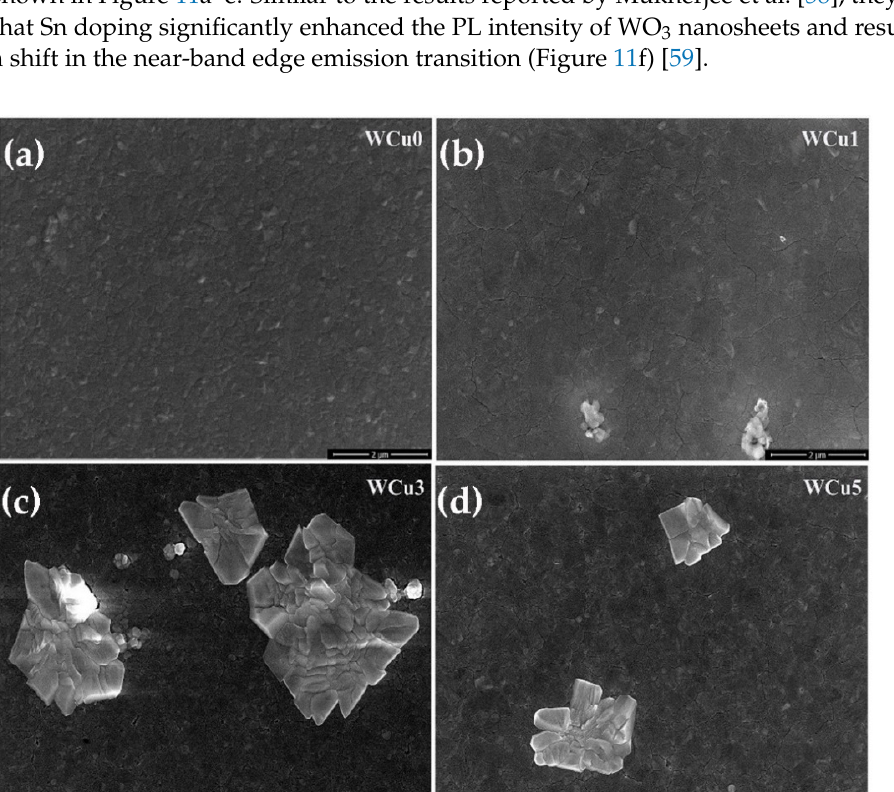
Figure 10. ( a – e ) FESEM images and ( f ) Photoluminescence emission spectra of the undoped and Cu doped WO 3 thin films. Reproduced or adapted from [60].